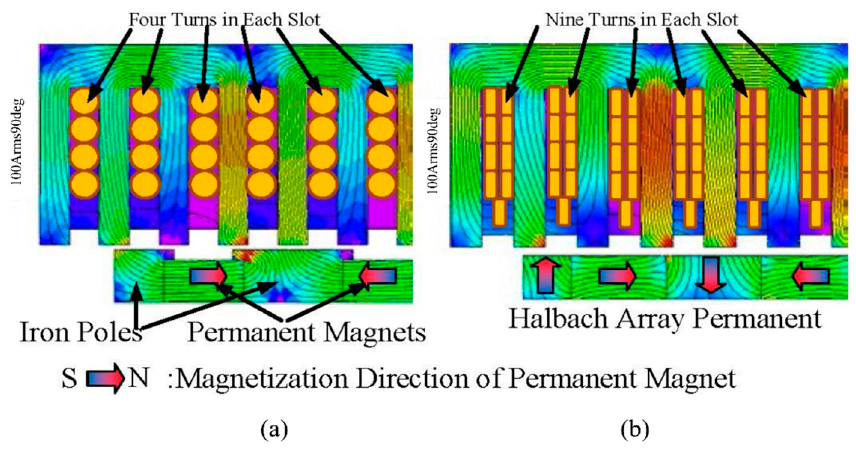
Figure 8. Two generations of prototype at Toyota Central R&D [1]. ( a ) First prototype; ( b ) Second prototype.